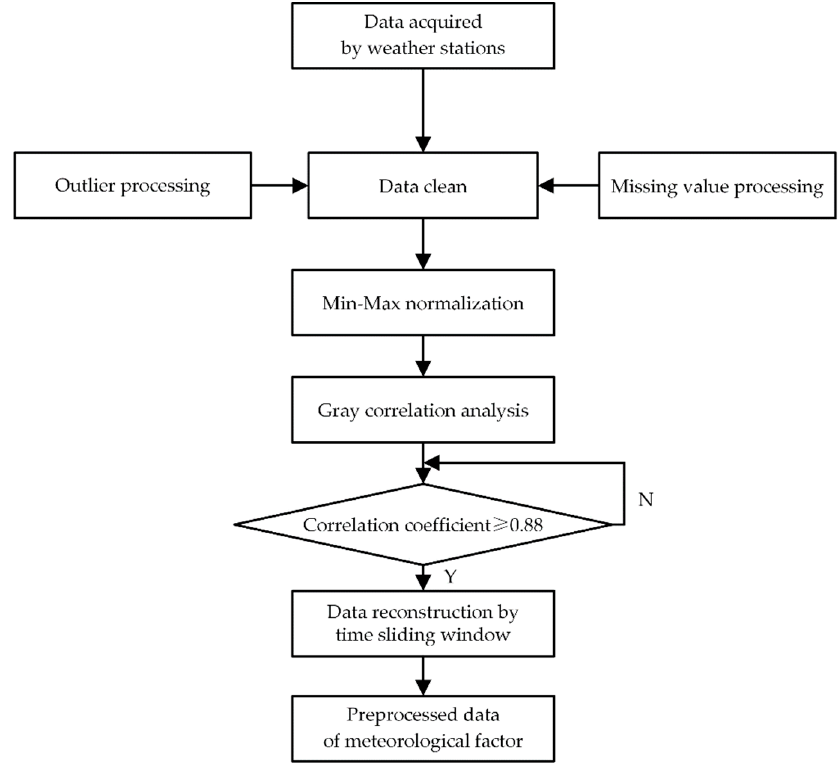
Figure 1. Data preprocessing process.